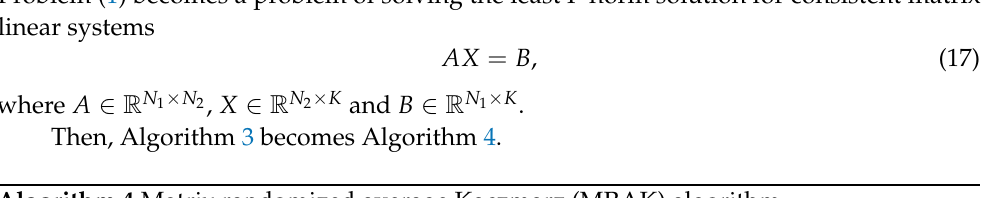
Algorithm 4 Matrix randomized average Kaczmarz (MRAK)